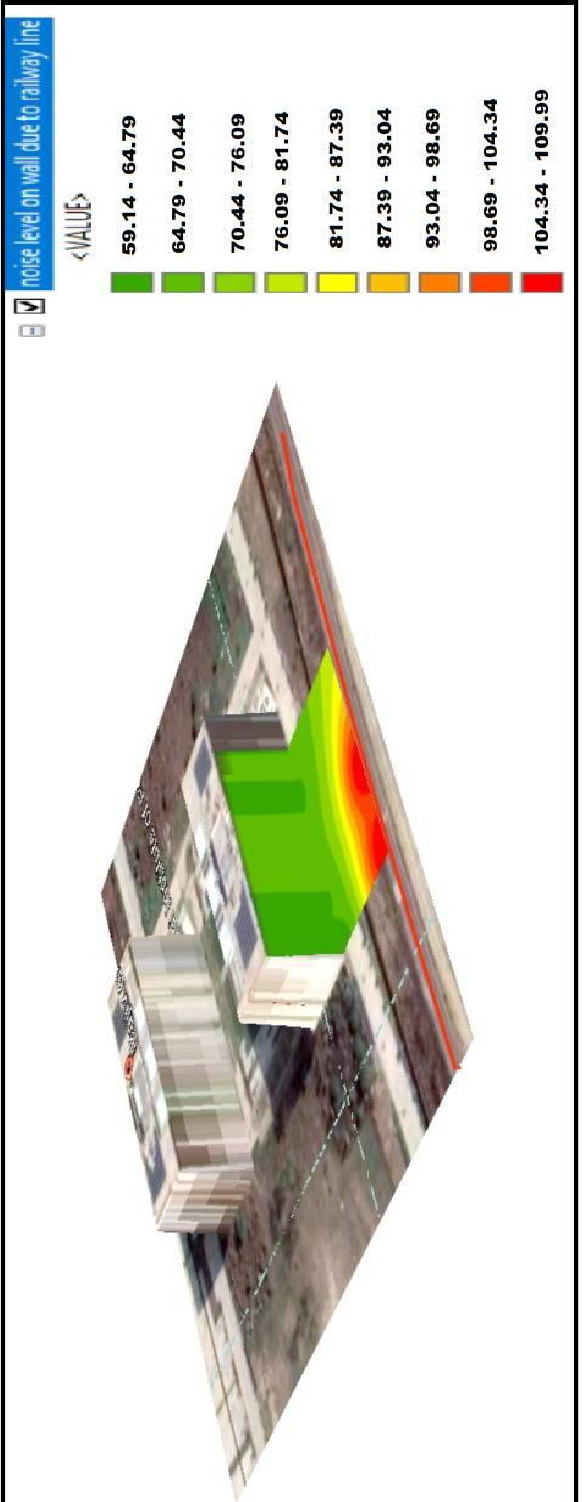
Figure 7. Railway Noise mapping on Sidewalls of AB2 Building. DEM is generated with LiDAR data This is the 3D Map of the RGIPT Academic Building AB1 and AB2 with the noise value around and over the building and